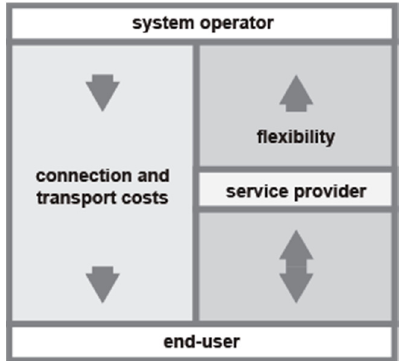
Figure 1. Abstract overview of the interactions between the distribution system operator (DSO) and a customer considered within this article.